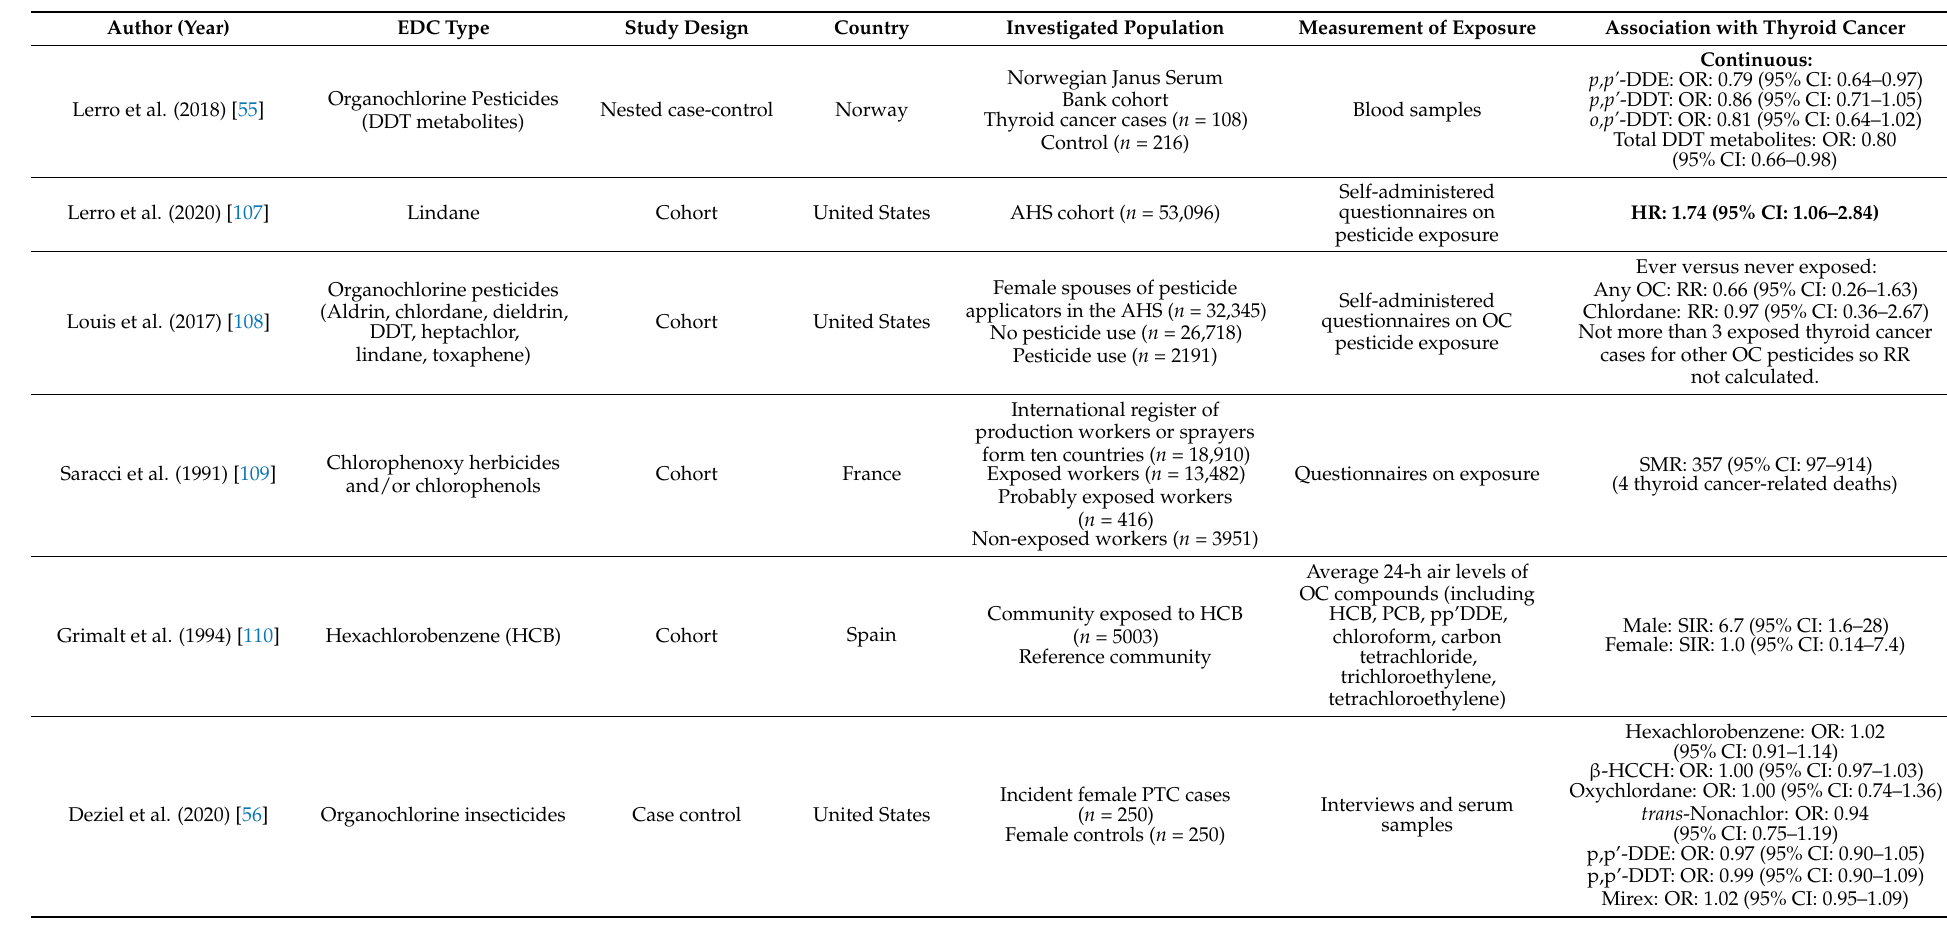
Table 6. Association between exposure to organochlorine and organophosphate pesticides and thyroid cancer. Abbreviations: AHS: Agricultural Health Study; CI: confidence interval; DDE: Dichlorodiphenyldichloroethylene; DDT: dichlorodiphenyltrichloroethane; EDC: endocrine disrupting chemicals; HCB: Hexachlorobenzene; HCCH: hexachlorocyclohexanes; HR: hazard ratio; OC: organochlorine; OP: organophosphate; OR: odds ratio; PCB: polychlorinated biphenyl; PCP: Pentachlorophenol; PTC: papillary thyroid cancer; RR: risk ratio; SIR: standardized incidence ratio; SMR: standardized mortality